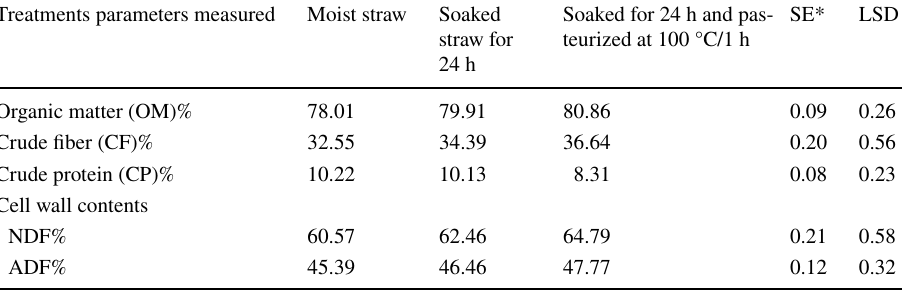
Table 6 Effect of some physical treatments on the nutritional quality of rice